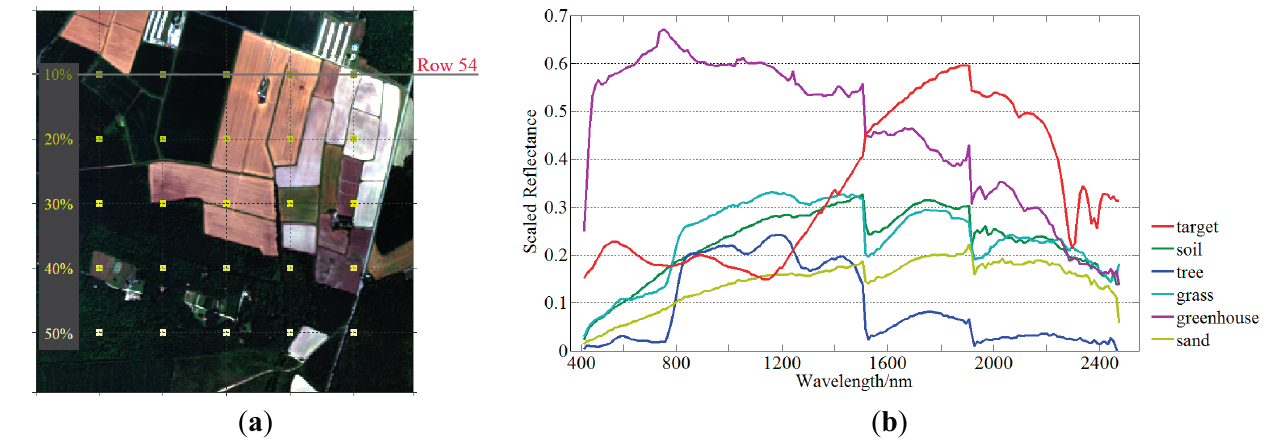
Figure 6. ( a ) Color rendering of the AVIRIS image and implanted target